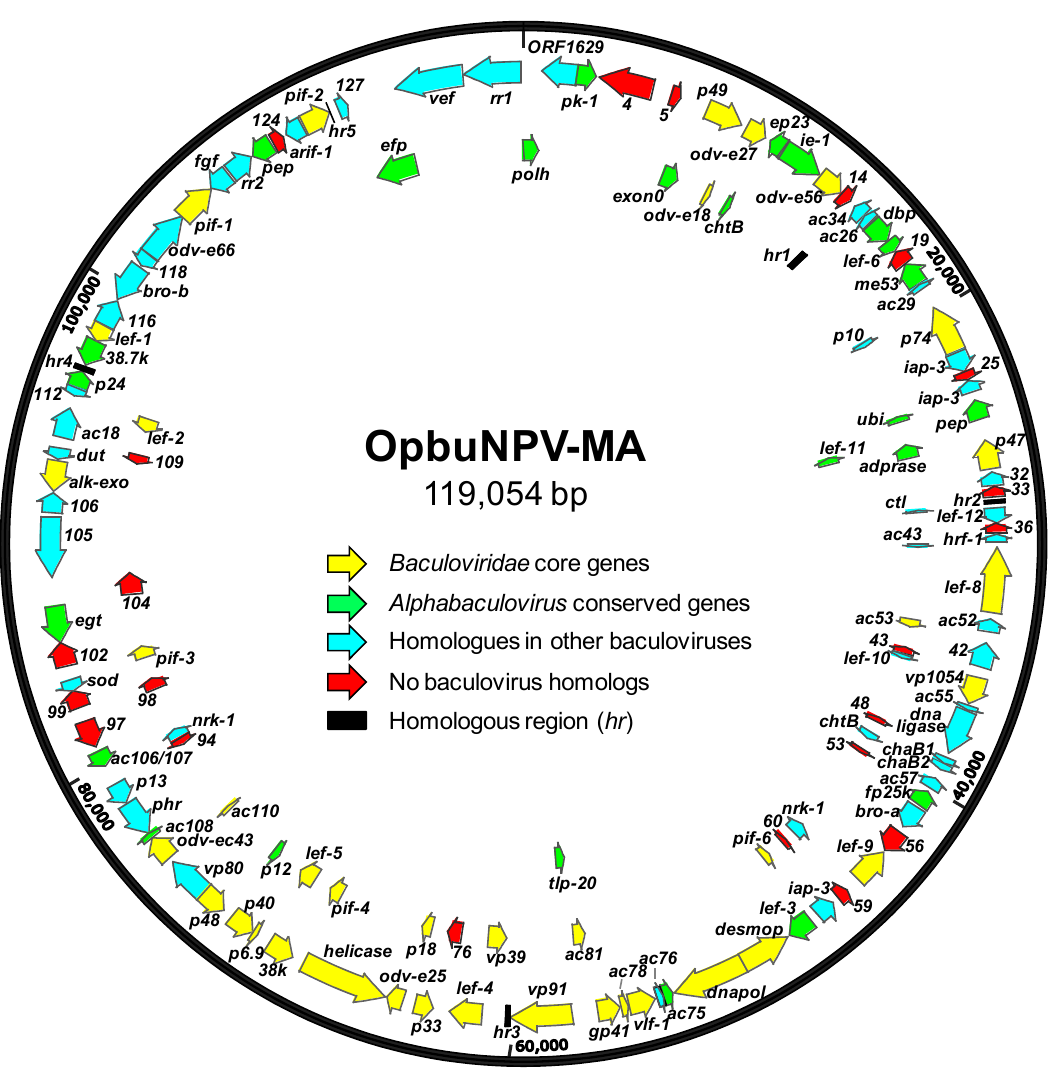
Figure 3. Map of the open reading frames (ORFs) and other features of the OpbuNPV-MA genome. ORFs are represented by arrows, with the position and direction of the arrow indicating ORF position and orientation. Each ORF is color-coded to indicate whether it corresponds to a baculovirus core gene, an ORF conserved among all alphabaculoviruses, an ORF with homologs in a subset of other baculoviruses, or an ORF with no baculovirus homologs. Homologous repeat regions ( hr s) are represented by black rectangles. ORFs are designated by names if they are conserved or well-characterized baculovirus homologs, or a number corresponding to its annotation in the genome.